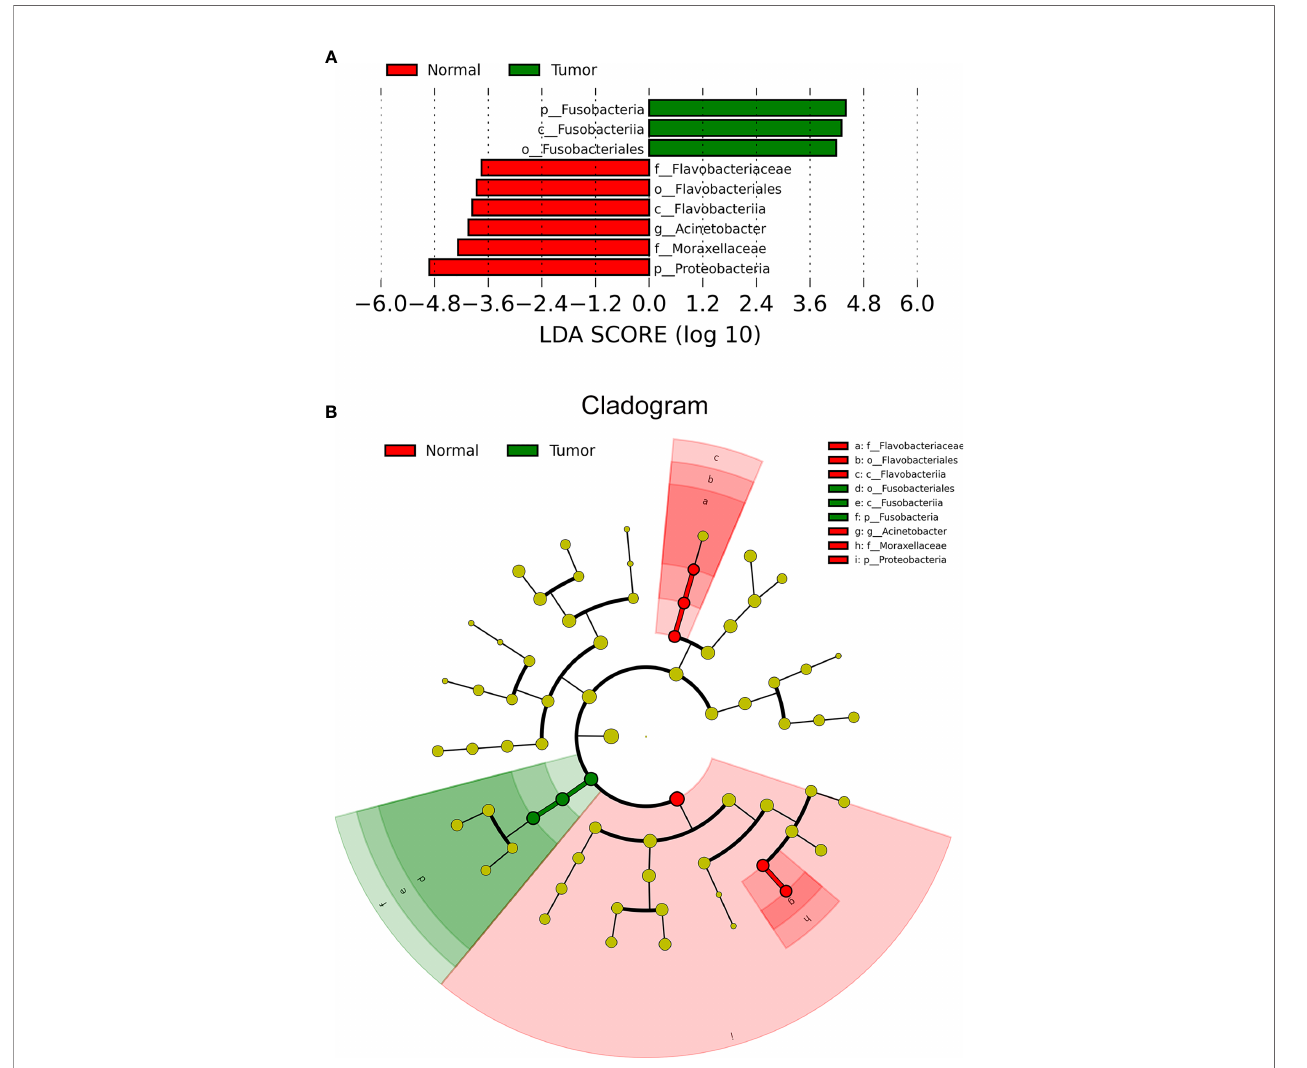
FIGURE 2 | LEfSe analysis identifying tumor- and normal-enriched microbiota. (A) The LDA score of speci fi c microbial taxa in the tumor group and normal group. Threshold LDA score is 2. (B) Cladogram showing tumor- and normal-enriched microbial taxa. LEfSe, linear discriminant analysis effect size; LDA, linear discriminant